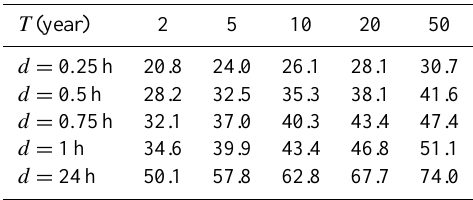
Table 3. Rainfall depths (mm) for return periods T (year), and ag- gregation times d (h) based on the adjusted IDF-curves of A-data at the station Rwerere-Colline (Rwanda).